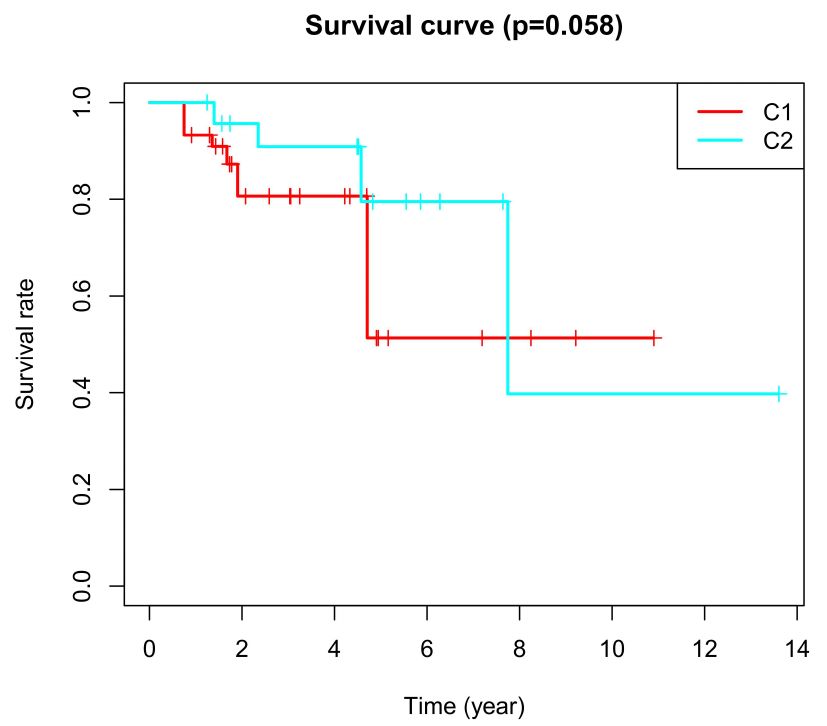
Figure 9. Kaplan–Meier curves. Kaplan–Meier curves based on CR and PR after chemotherapy with a log-rank test. C1 represents cluster 1 and C2 represents cluster